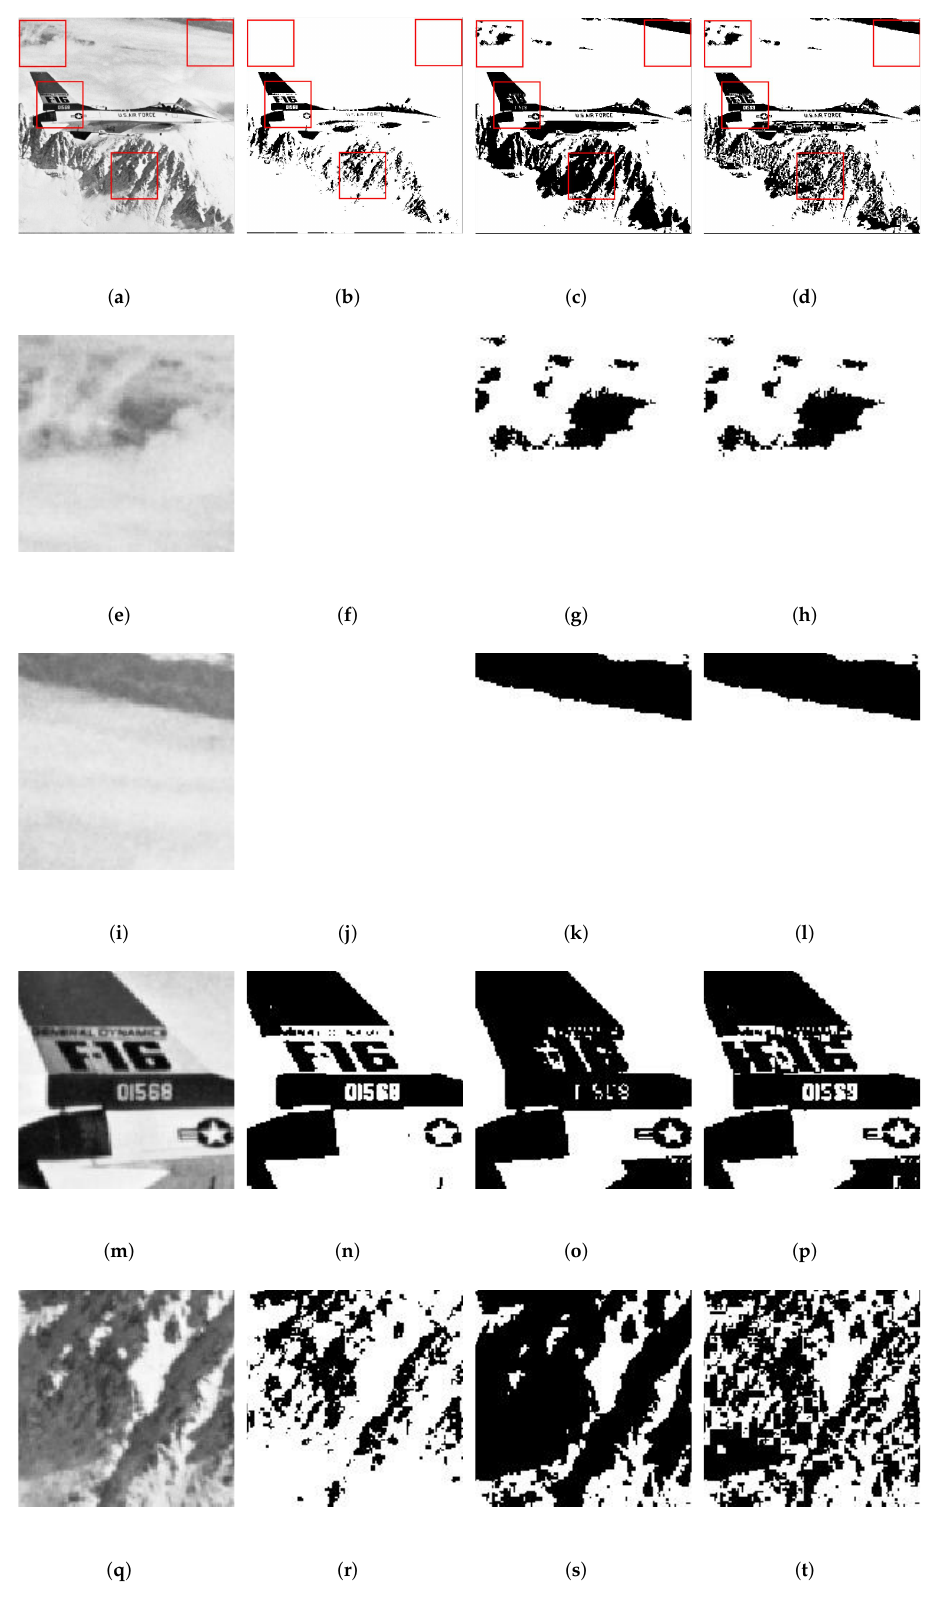
Figure 5. Plane image segmentation renderings and partial enlarged images under different algo- rithms. ( a ) is the original image of plane, ( b ) is the segmentation effect of the rough set method, ( c ) is the segmentation effect of the PSO method, ( d ) is the combined segmentation effect of the two methods, ( e – t ) are the corresponding partial enlarged